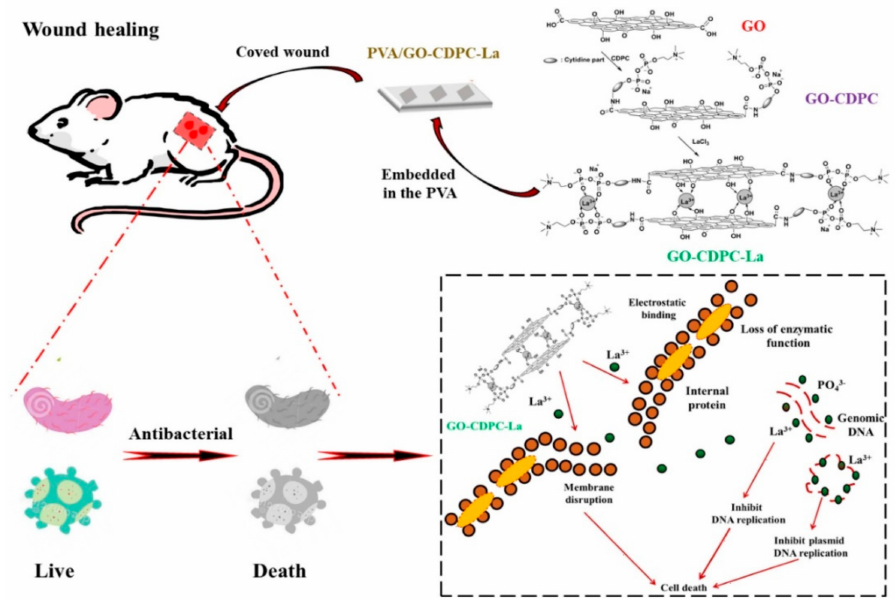
Figure 8. Schematic illustration of PVA antibacterial film embedded with GO-CDPC-La for antibacte- rial wound dressings. Data reproduced with permission from Ref.